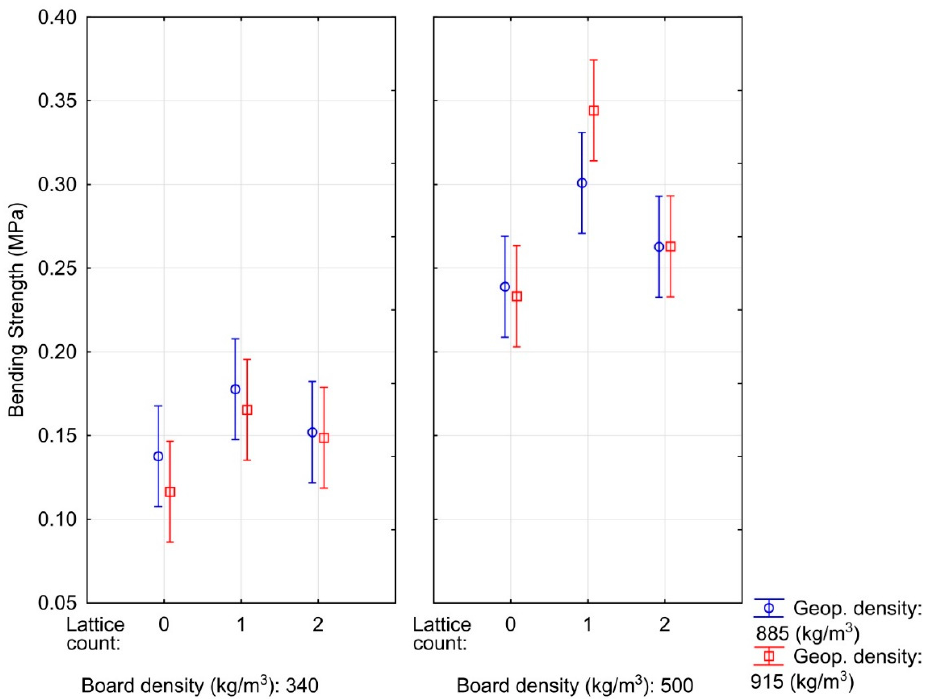
Figure 2. Influence of particleboard density, geopolymer density and the number of lattices on the bending strength of composite materials.